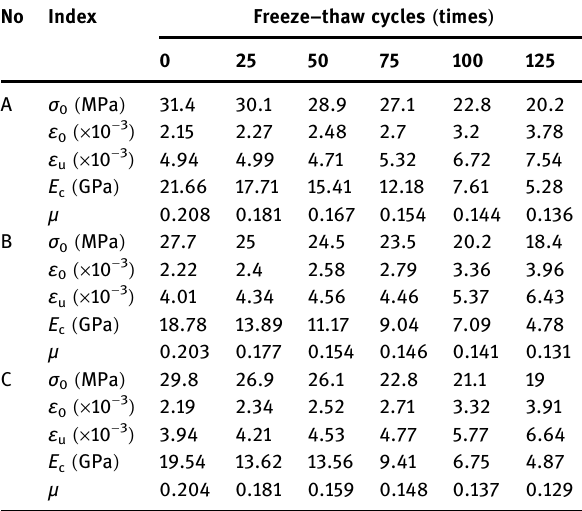
Table 3: Uniaxial compressive performance index